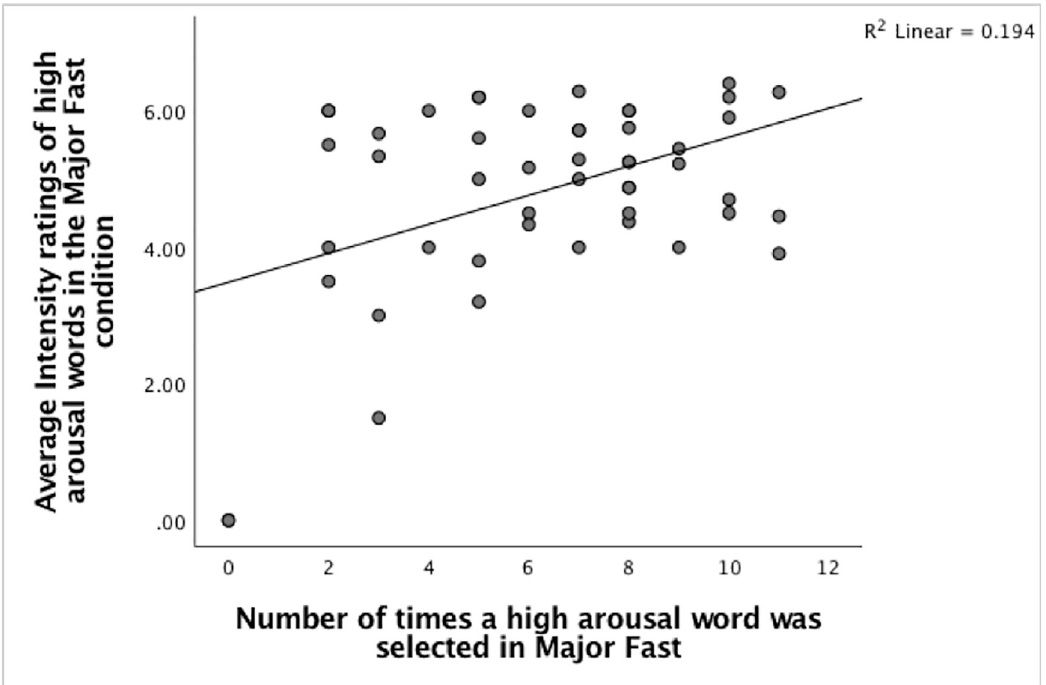
Fig 13. The relationship between the number of high arousal words selected and the rated intensities in the Major-Fast condition.